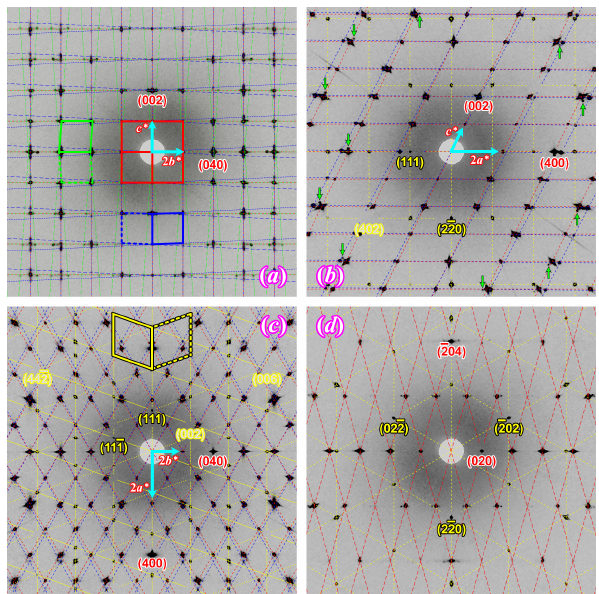
Figure 7. Reconstructed sections of the reciprocal space from the SC-XRD data of Crystal 1. (a) 0kl image of oligoclase; (b) h0l im- age of orthoclase; (c) hk0 image of orthoclase; (d) hk h + k image of magnetite film. The reciprocal lattice of orthoclase (dashed red lines), oligoclase (Albite twin law, dash-dotted green lines), albite (Pericline twin law, dash-dotted blue lines) and magnetite (Spinel twin law, dash-dotted yellow lines) are labeled with dash-dotted lines of different colors. The reciprocal unit cells are marked by the same color in (a) and (c) to clarify the lattices of different twin domains. Miller indices of a few characteristic reflections are also marked for orthoclase and one of the magnetite twin domains using the same color code. The albite reflections are not indexed as they are closely related to the adjacent orthoclase reflections.